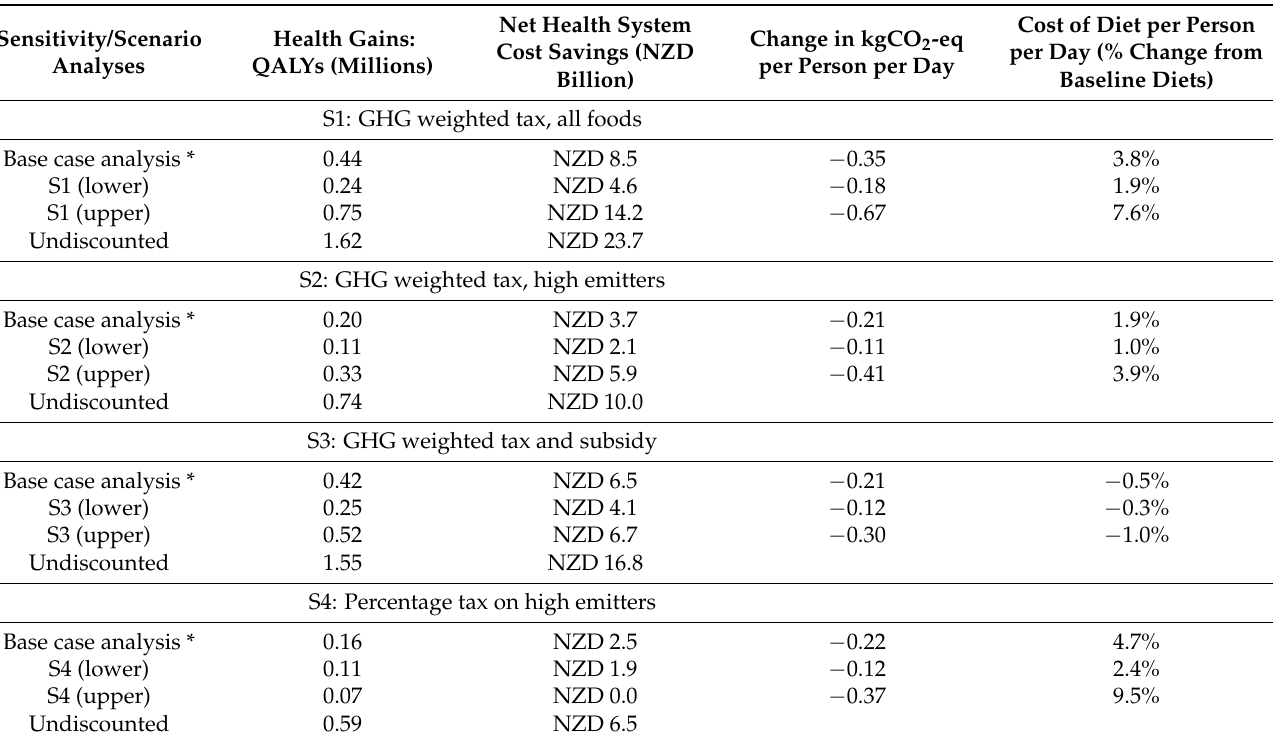
Table 3. Health, health system cost and GHG emission impacts of sensitivity and further scenario analyses around the base case for each